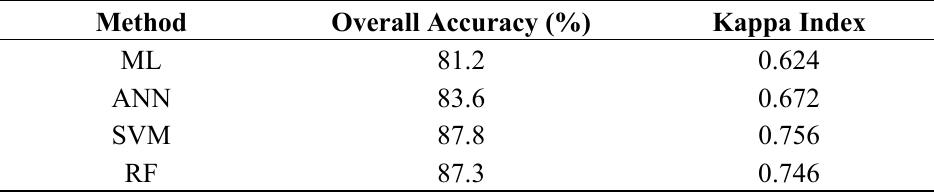
Table 4. Accuracy comparison results of RF and other